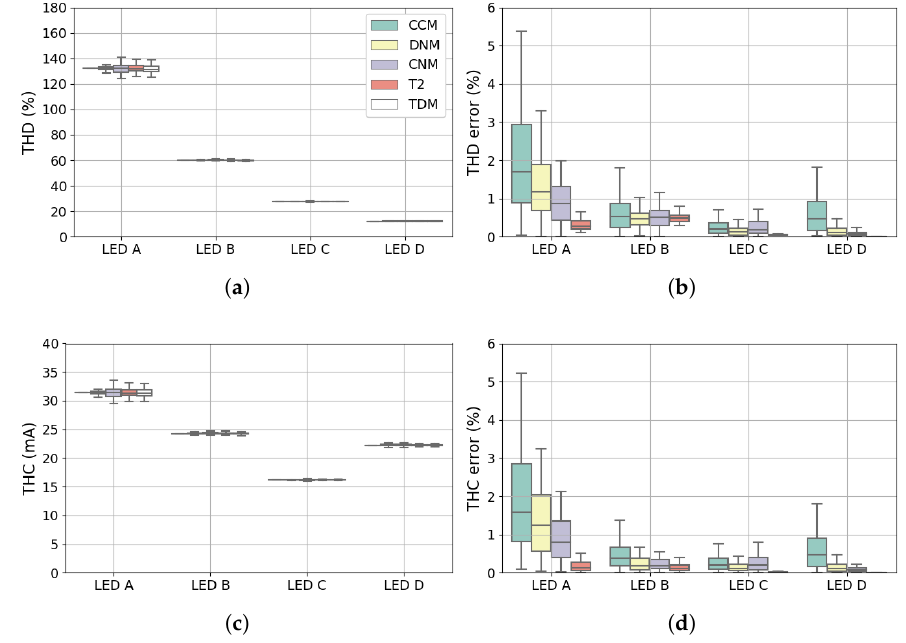
Figure 21. Comparison of the summary indices obtained with different frequency domain models supplied with flat-top voltage: ( a ) THD; ( b ) THD error (relative); ( c ) THC; and ( d ) THC error (relative).